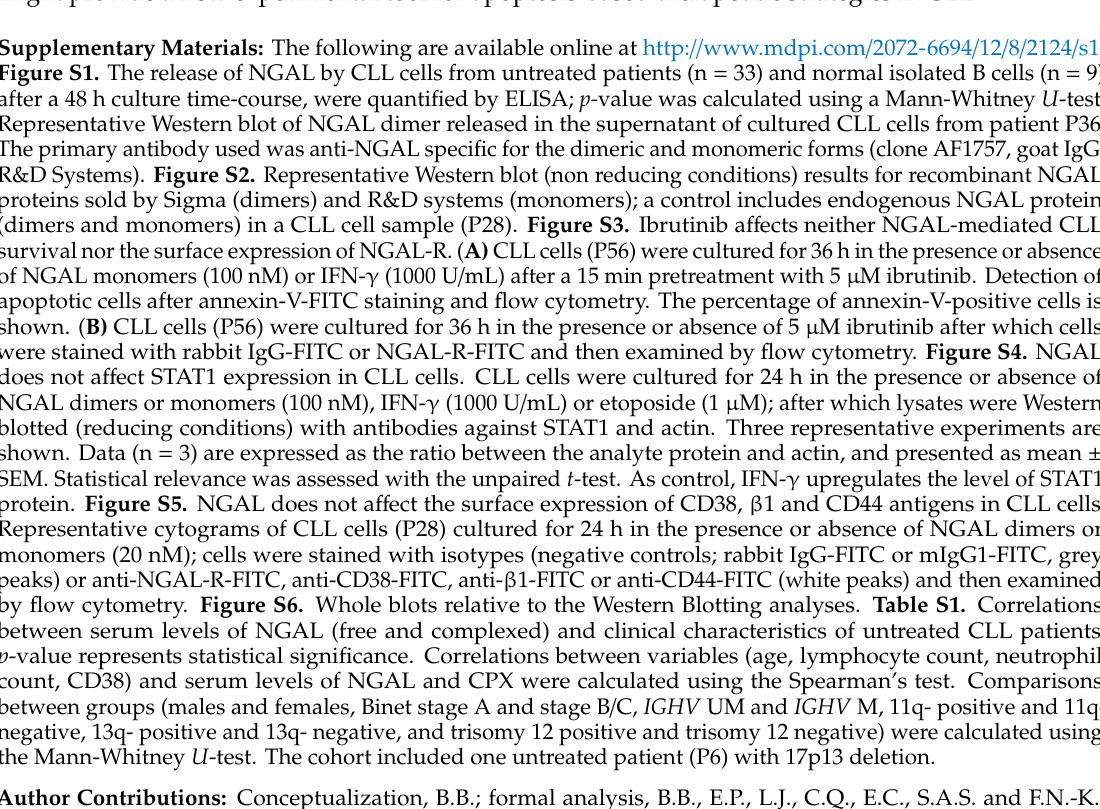
Figure S1. The release of NGAL by CLL cells from untreated patients (n = 33) and normal isolated B cells (n = 9) after a 48 h culture time-course, were quantified by ELISA; p- value was calculated using a Mann-Whitney U -test. Representative Western blot of NGAL dimer released in the supernatant of cultured CLL cells from patient P36. The primary antibody used was anti-NGAL specific for the dimeric and monomeric forms (clone AF1757, goat IgG; R&D Systems). Figure S2. Representative Western blot (non reducing conditions) results for recombinant NGAL proteins sold by Sigma (dimers) and R&D systems (monomers); a control includes endogenous NGAL protein (dimers and monomers) in a CLL cell sample (P28). Figure S3. Ibrutinib a ff ects neither NGAL-mediated CLL survival nor the surface expression of NGAL-R. ( A) CLL cells (P56) were cultured for 36 h in the presence or absence of NGAL monomers (100 nM) or IFN- γ (1000 U / mL) after a 15 min pretreatment with 5 µ M ibrutinib. Detection of apoptotic cells after annexin-V-FITC staining and flow cytometry. The percentage of annexin-V-positive cells is shown. ( B) CLL cells (P56) were cultured for 36 h in the presence or absence of 5 µ M ibrutinib after which cells were stained with rabbit IgG-FITC or NGAL-R-FITC and then examined by flow cytometry. Figure S4. NGAL does not a ff ect STAT1 expression in CLL cells. CLL cells were cultured for 24 h in the presence or absence of NGAL dimers or monomers (100 nM), IFN- γ (1000 U / mL) or etoposide (1 µ M); after which lysates were Western blotted (reducing conditions) with antibodies against STAT1 and actin. Three representative experiments are shown. Data (n = 3) are expressed as the ratio between the analyte protein and actin, and presented as mean ± SEM. Statistical relevance was assessed with the unpaired t -test. As control, IFN- γ upregulates the level of STAT1 protein. Figure S5. NGAL does not a ff ect the surface expression of CD38, β 1 and CD44 antigens in CLL cells. Representative cytograms of CLL cells (P28) cultured for 24 h in the presence or absence of NGAL dimers or monomers (20 nM); cells were stained with isotypes (negative controls; rabbit IgG-FITC or mIgG1-FITC, grey peaks) or anti-NGAL-R-FITC, anti-CD38-FITC, anti- β 1-FITC or anti-CD44-FITC (white peaks) and then examined by flow cytometry. Figure S6. Whole blots relative to the Western Blotting analyses. Table S1. Correlations between serum levels of NGAL (free and complexed) and clinical characteristics of untreated CLL patients. p -value represents statistical significance. Correlations between variables (age, lymphocyte count, neutrophil count, CD38) and serum levels of NGAL and CPX were calculated using the Spearman’s test. Comparisons between groups (males and females, Binet stage A and stage B / C, IGHV UM and IGHV M, 11q- positive and 11q- negative, 13q- positive and 13q- negative, and trisomy 12 positive and trisomy 12 negative) were calculated using the Mann-Whitney U -test. The cohort included one untreated patient (P6) with 17p13